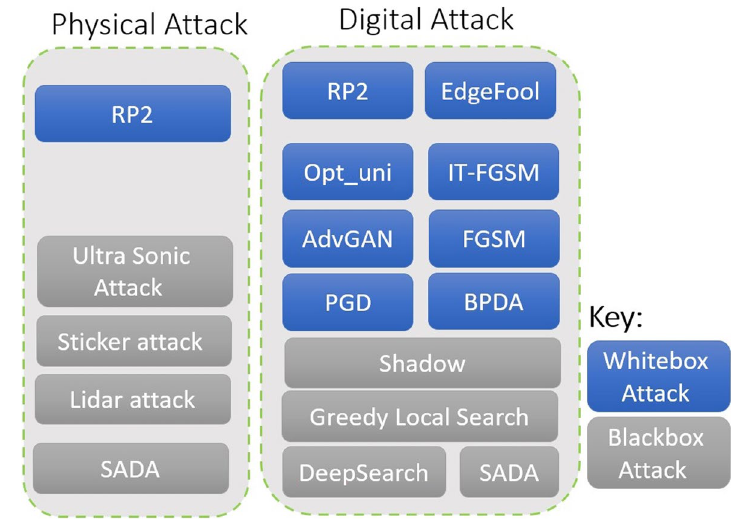
Fig. 8 Taxonomy of adversarial attack